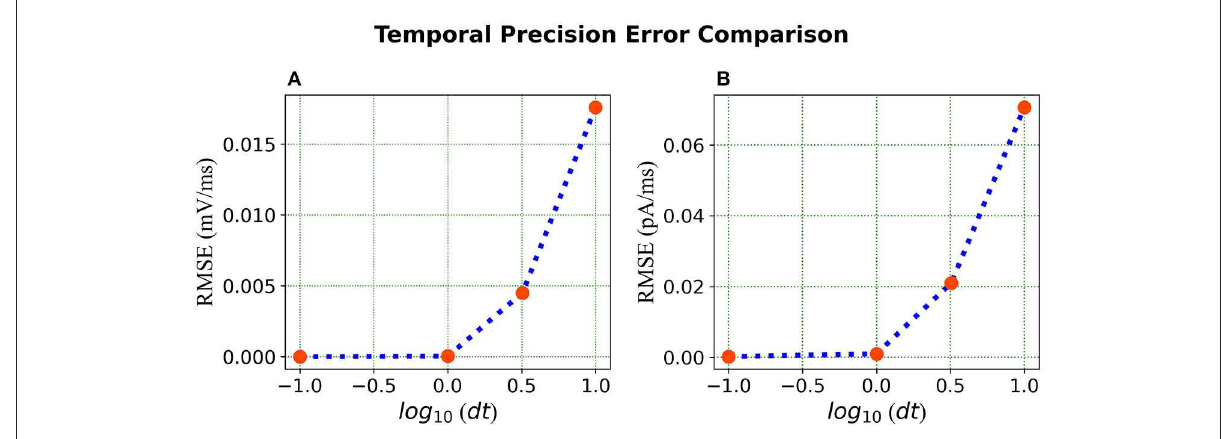
FIGURE7 Error comparison for different temporal precisions— (A) Membrane potential error. (B) Current error. In both panels, the RMSE for the corresponding state is plotted against the log of the temporal precision dt .